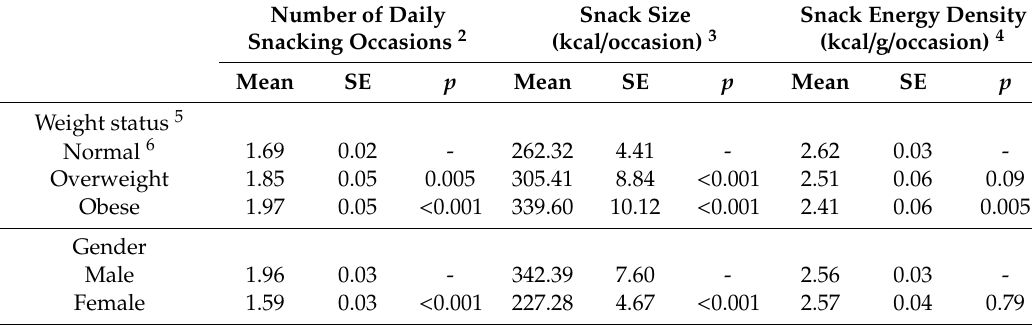
Table 2. Snack parameters (food and beverages) by adolescent demographic characteristics ( n = 6545) 1